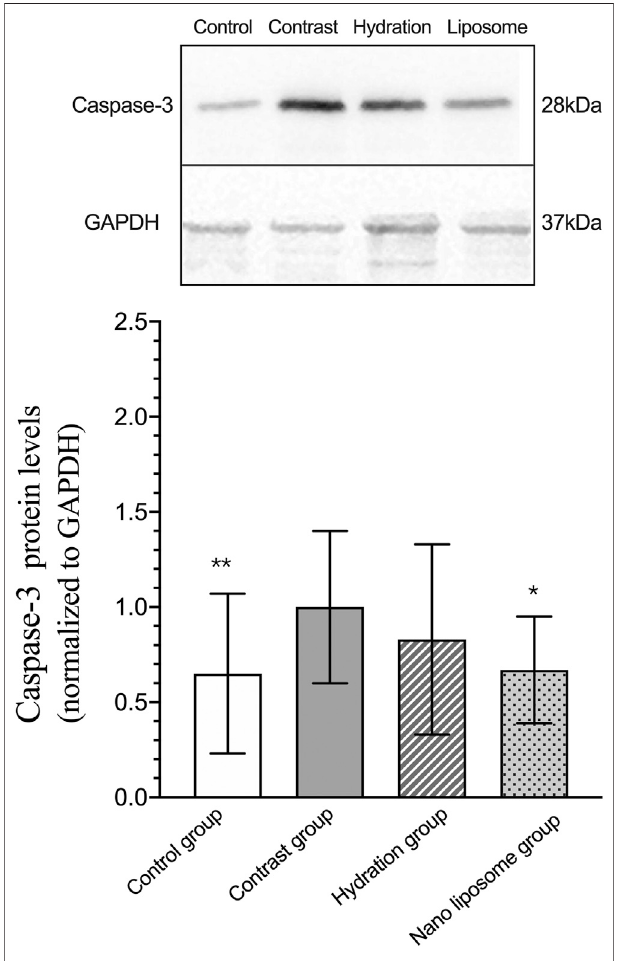
FIGURE 11 | Representative western blot results and analysis of the Caspase-3 protein expression in the four groups. Caspase-3 (cid:2) cysteine aspartate speci fi c protease 3. Values are expressed as mean ± SD. *Compared with the contrast group, p < 0.05. **Compared with the contrast group, p < 0.01. # Compared with the hydration group, p < 0.05. ## Compared with the hydration group, p < 0.01.